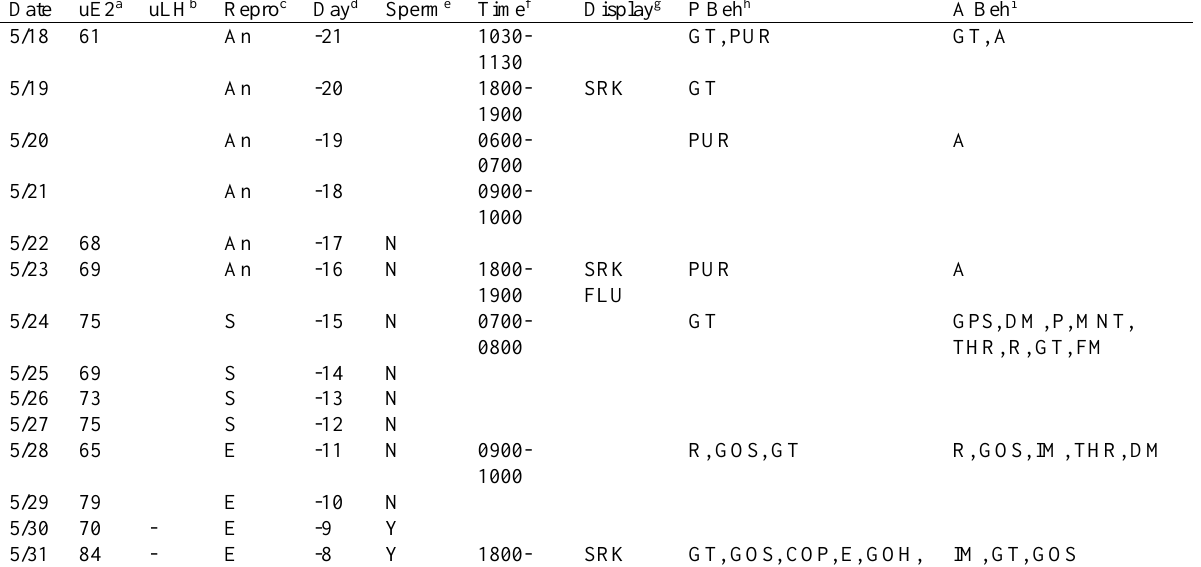
Animal 1 Reproductive Behavior, Endocrinology, Copulation, and Day of